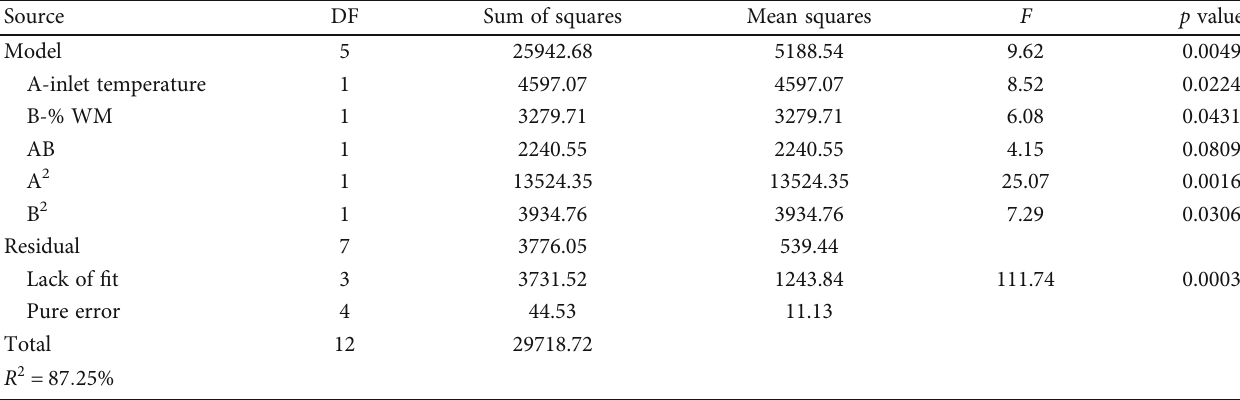
Table 6: Analysis of variance of the e ff ect of temperature ( ° C) and wall material (%), adjusted to a quadratic model, on the content of encapsulated phenolic compounds recovered after the encapsulation process.